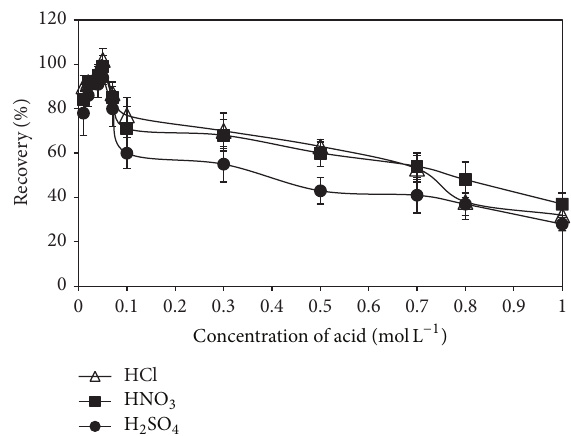
Figure 1: Effect of the acidity of the sample solution on the recovery of Bi(III) ions by using the proposed DLLME procedure.